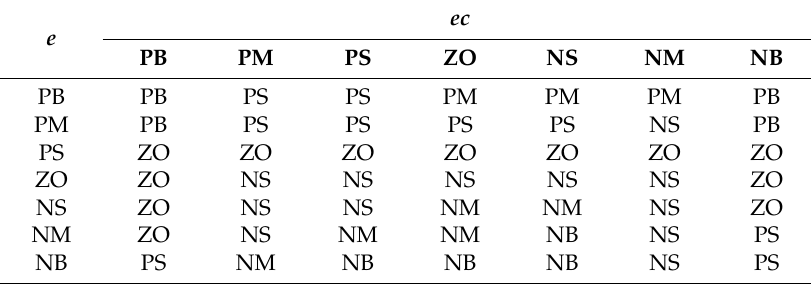
Table 4. Fuzzy control rule table of (cid:52) k d